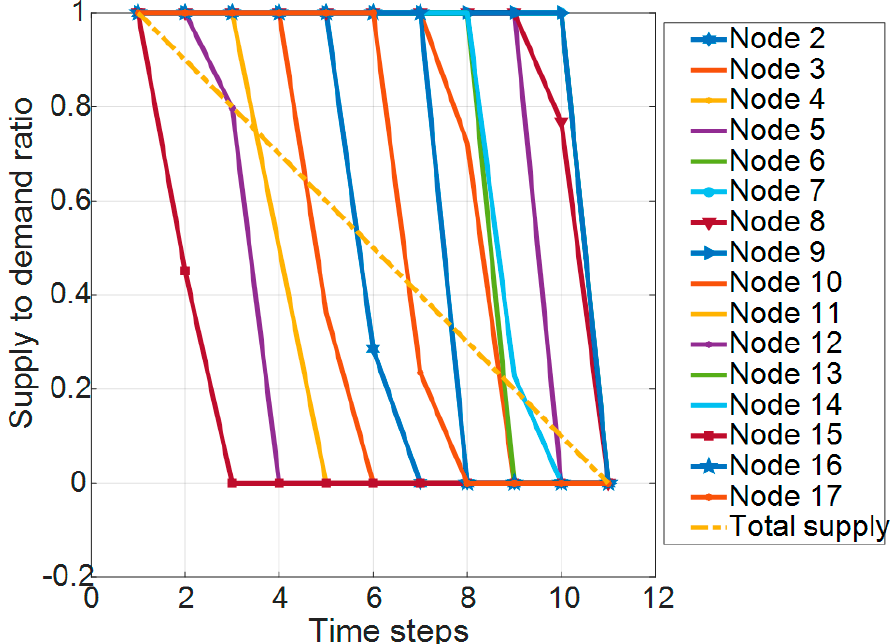
Figure 4. The percentage of demand supplied to each consumer node of the network (Figure 3) under 10%/hour reduction of the total supply for the baseline case (scenario S0 in Table A1).